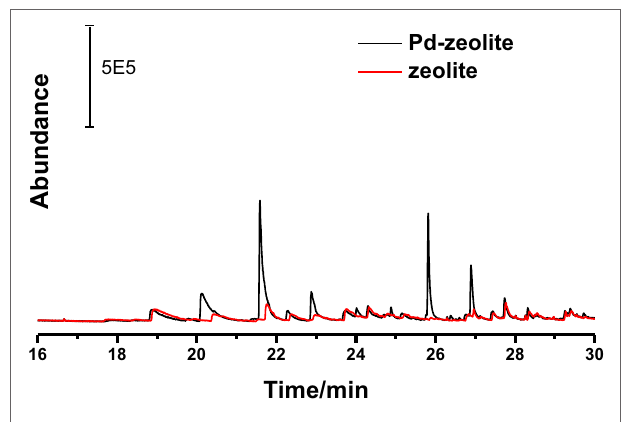
FIGURe 7 | GC–MS spectrum of the products from lignin depolymerization on Pd-zeolite Y and zeolite at